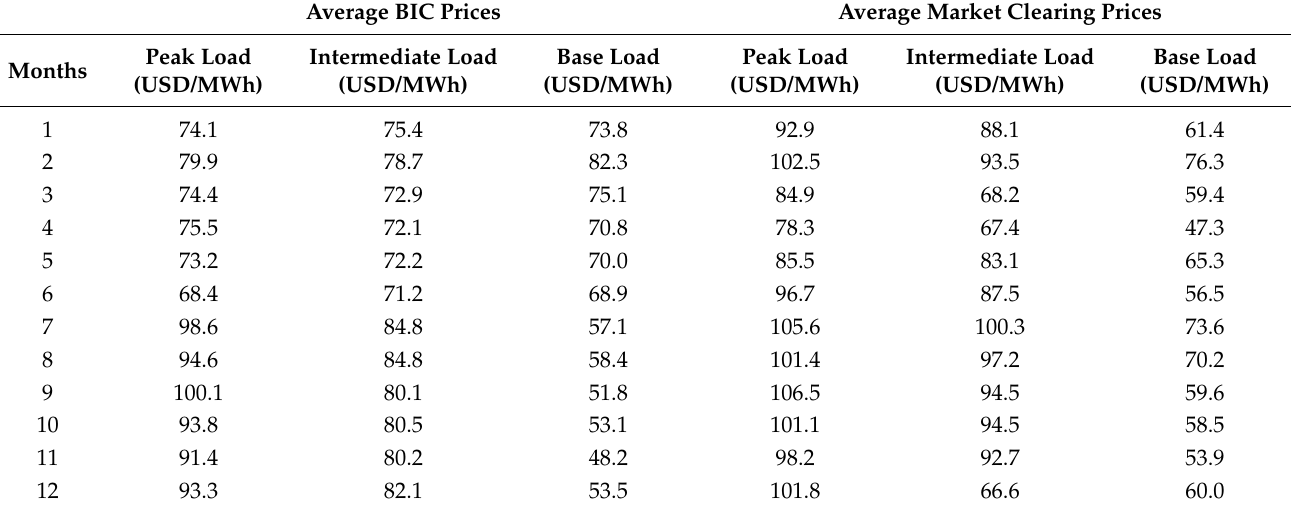
Table 1. BIC and market-clearing prices for the base year